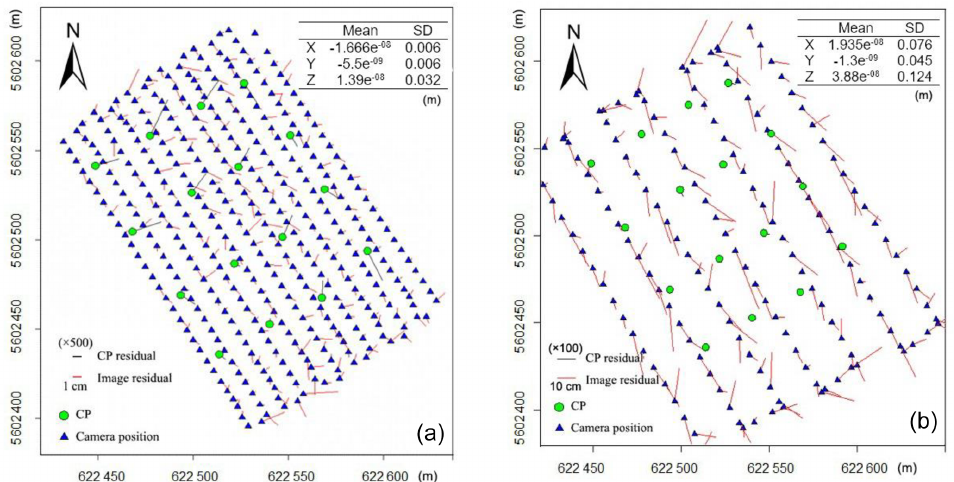
Figure A2. Residuals on the images and CPs in planimetric view. Vectors give the horizontal residual component magnified by × 500 for the DSLR survey (a) and × 100 for the action camera survey (b) . Inset: mean value and standard deviation of the image